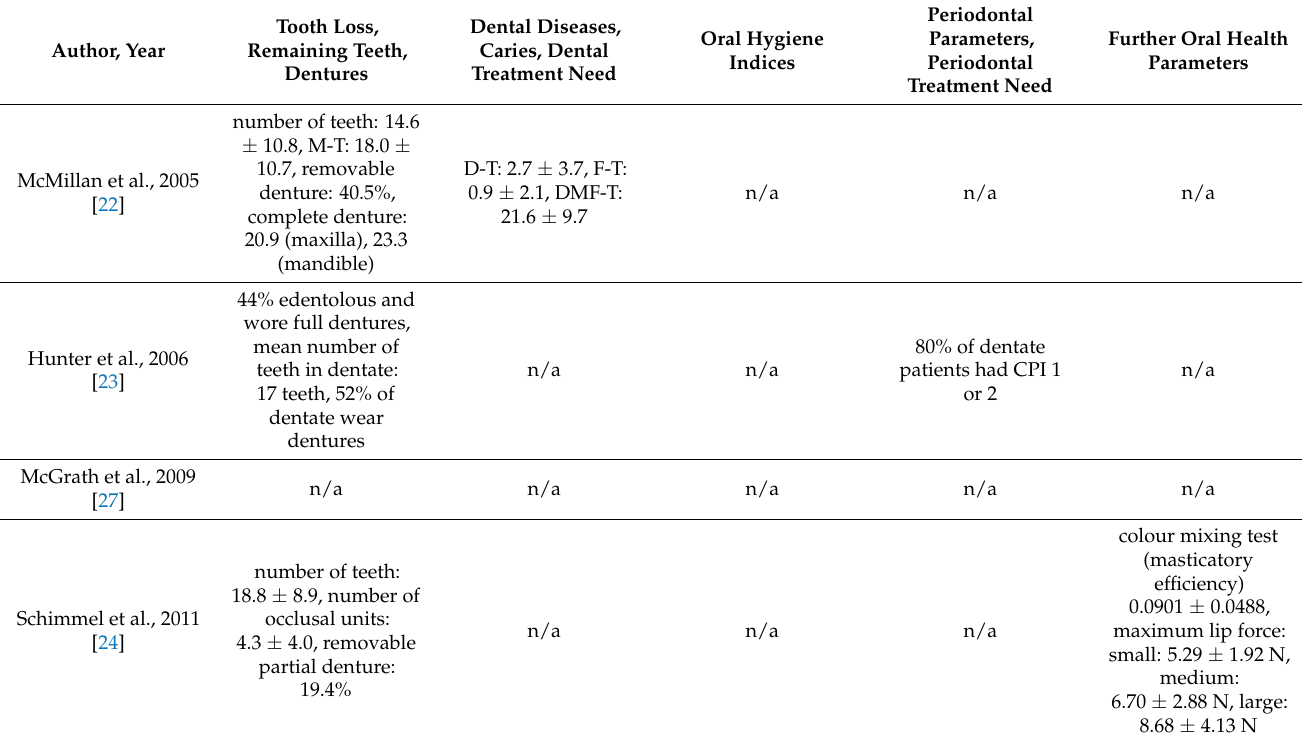
Table 3. Oral health parameters and respective main results across included studies. Findings are given as the mean values ± standard deviation or